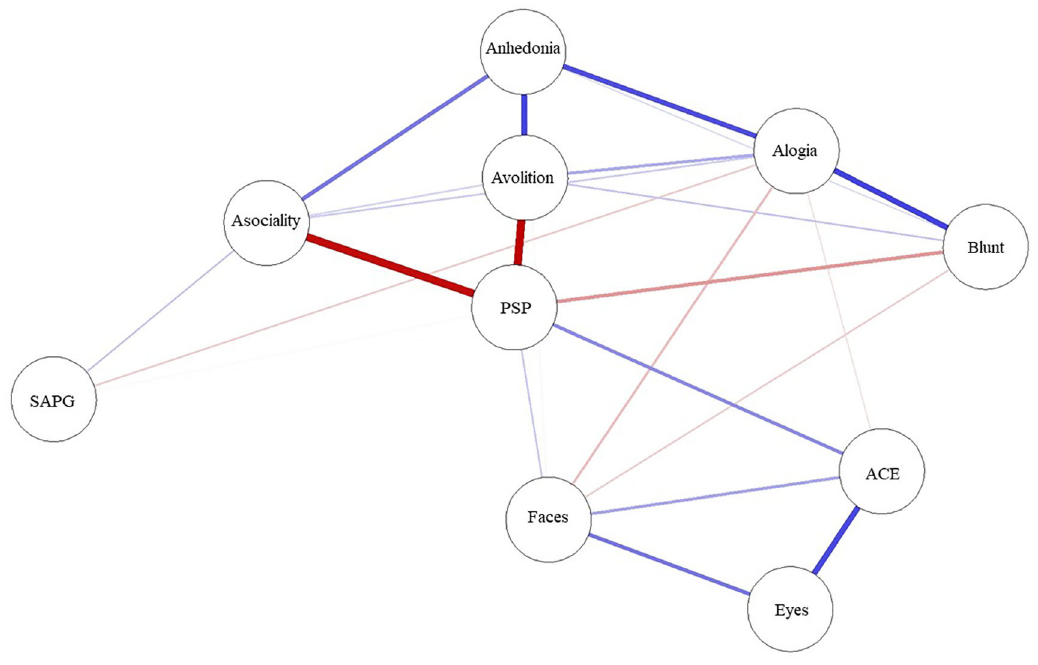
Figure 1. Network analysis of functioning, symptoms, neurocognition and social cognition scores. ACE: Addenbrooke ’ s Cognitive Examination III; Blunt: blunted affect; Eyes: Reading the Mind in the Eyes test; Faces: Faces test; PSP: Personal and Social Performance scale; SAPG: global Scale for the Assessment of Positive Symptoms